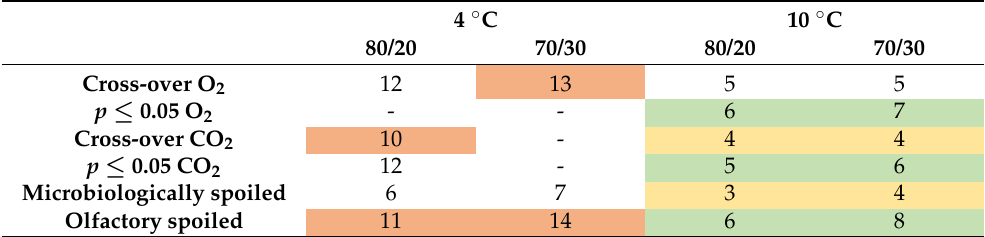
Table 2. Possible correlations between the tested parameters; p ≤ 0.05 represents the first day where the difference between empty and filled trays was significant with p ≤ 0.05, after the cross-over was reached. “Microbiologically spoiled” indicates a TVC of 10 7 CFUg − 1 and “olfactory spoiled” shows the panel classification of the sensory panel with >50 scores. A description of the color correlations can be found in the previous